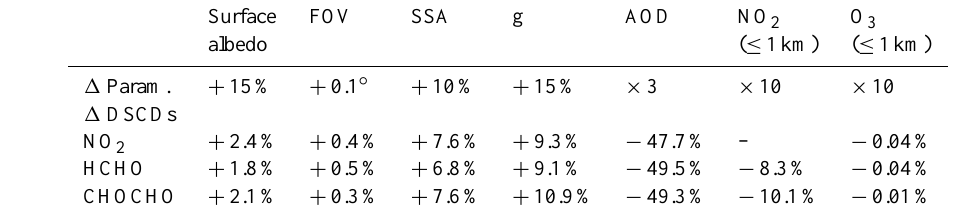
Table 3. Sensitivities of the RTM inputs on the calculated NO 2 , HCHO, and CHOCHO DSCDs.